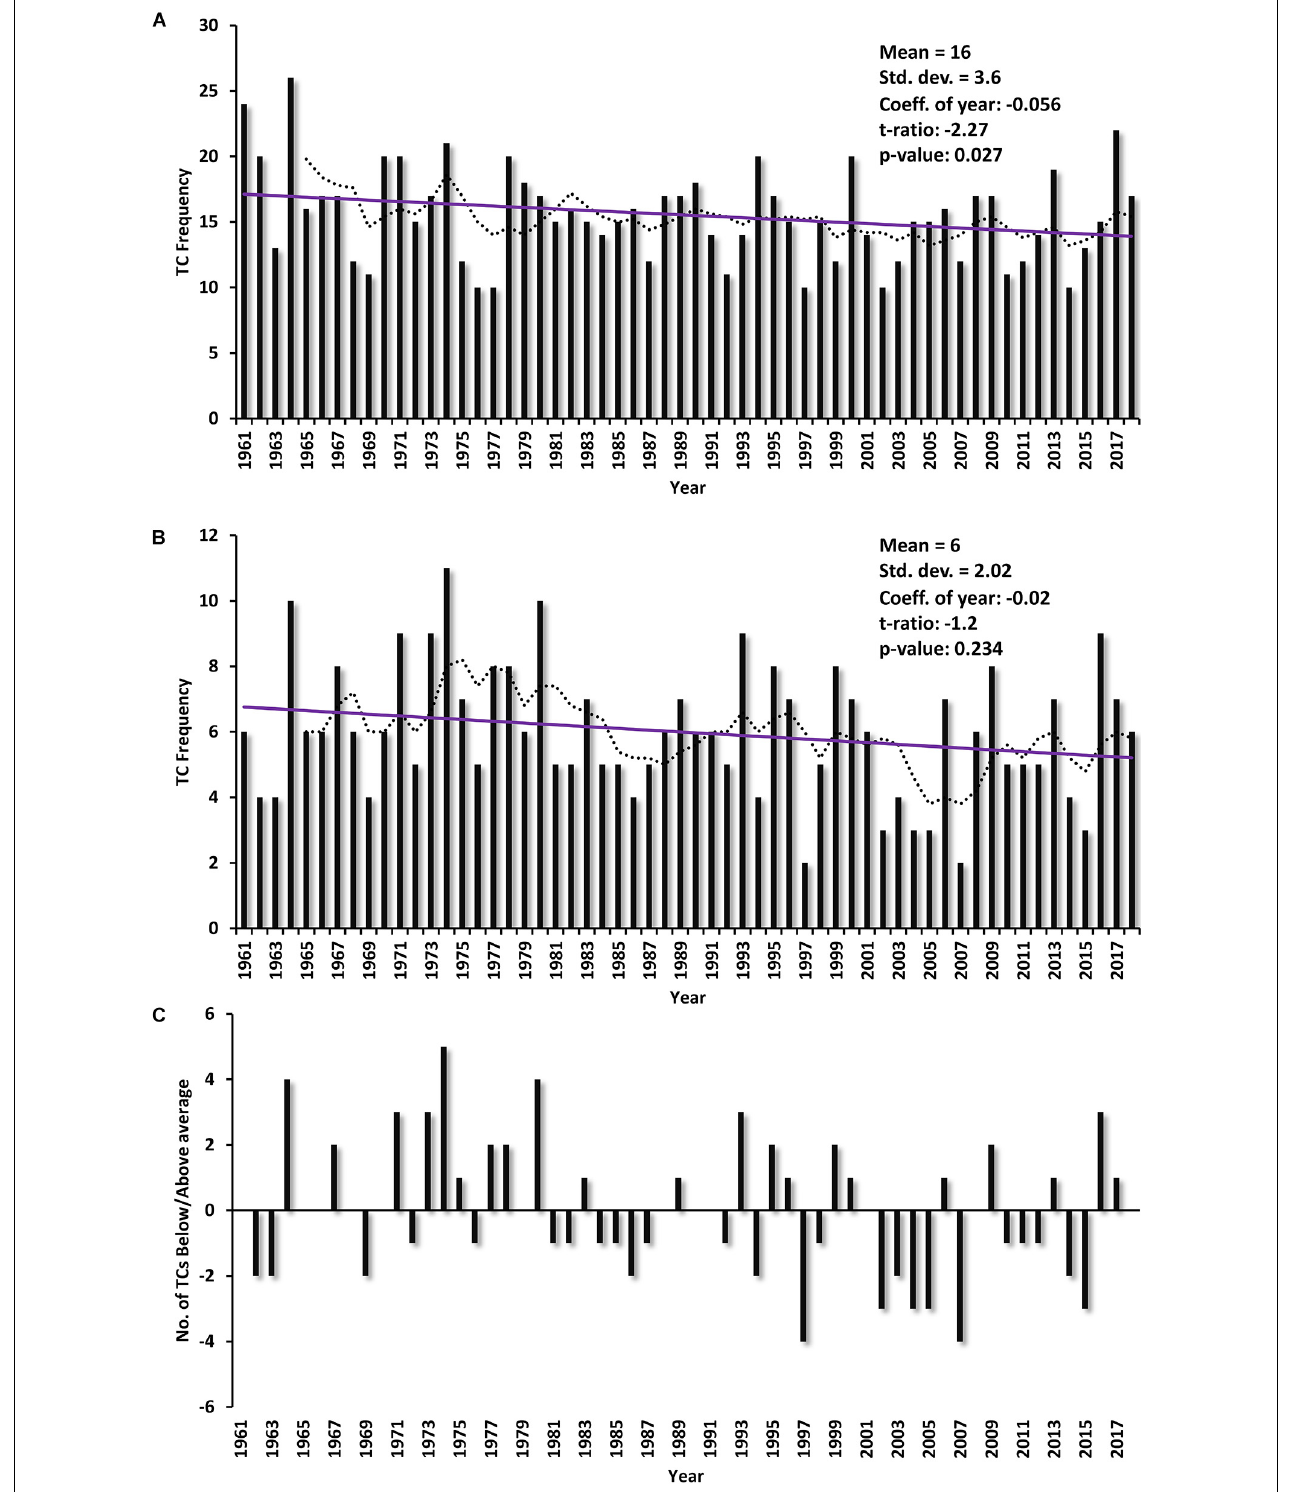
FIGURE 3 | (A) Total number of TCs within the jurisdiction of Hong Kong (600 km radius as described in the Tropical Cyclone Annual Publications: www.hko.gov.hk). (B) Number of TCs affecting Hong Kong, and (C) number of TCs above or below overall average. The solid purple lines in (A,B) show the long-term trend (correlation between the series and time) at a confidence interval of 95% ( p = 0.05) and the dotted black lines are the 5-year moving averages. All the data are for the period 1960–2018.